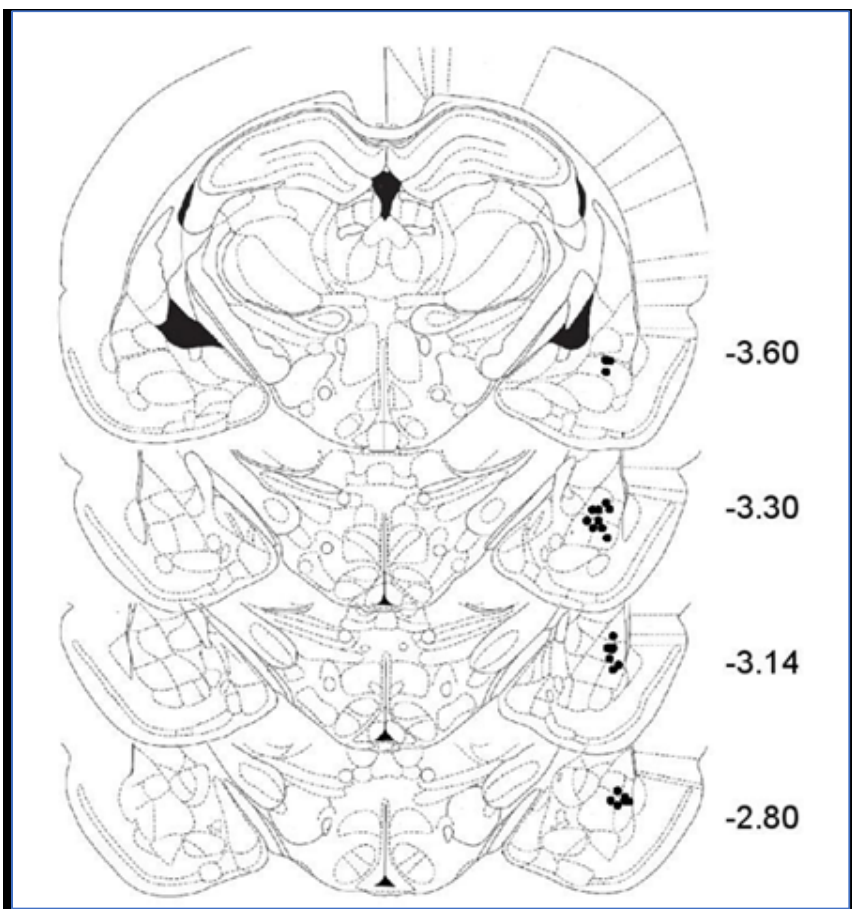
Figure 6. Diagram of coronal sections of the rat brain showing electrode placements in the basolateral amygdala (the figure presents all BLA electrode placements of animals used for Figure 3, but the locations of all electrodes in all animals were verified, and only animals with electrodes in the correct location were included in the analysis).